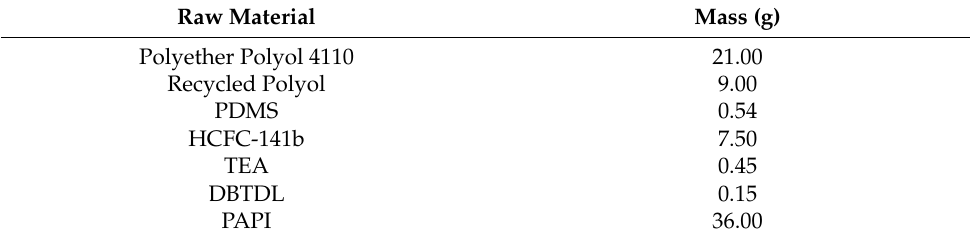
Table 1. Foaming ratio of recycled polyurethane hard